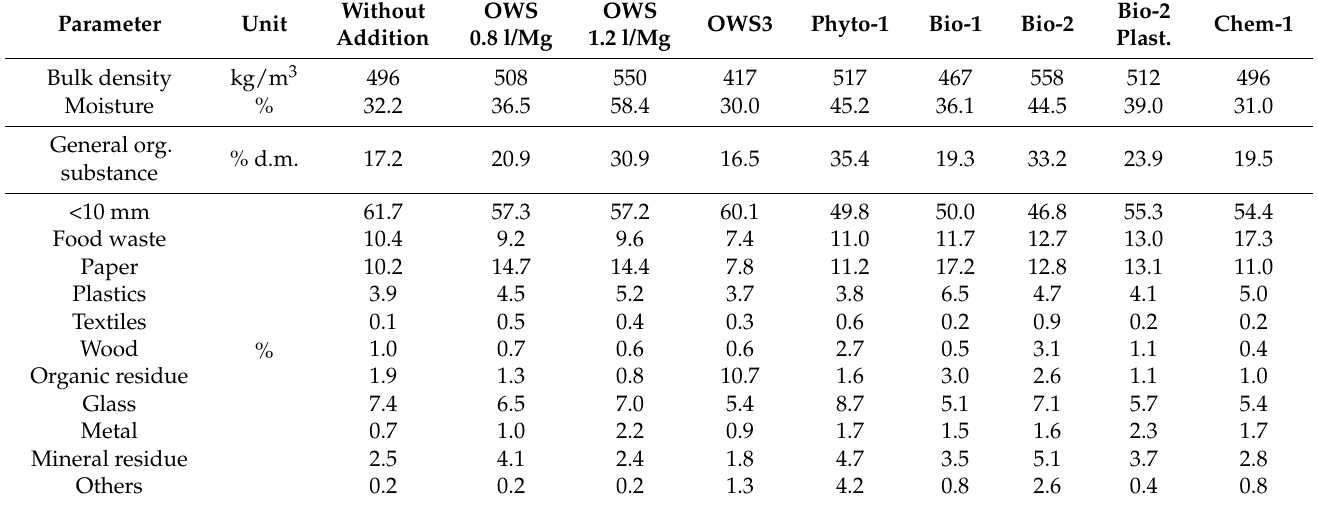
Table 2. Summary of physicochemical and morphological parameters of waste deposited in the examined windrows— evaluation of individual